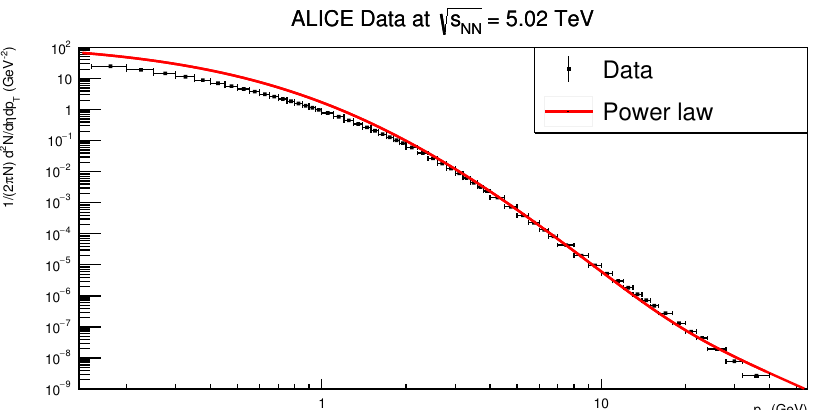
Figure 7. Two term power law (cid:12)t to the (cid:12)rst ALICE data set. A 3 GeV cuto(cid:11) has been